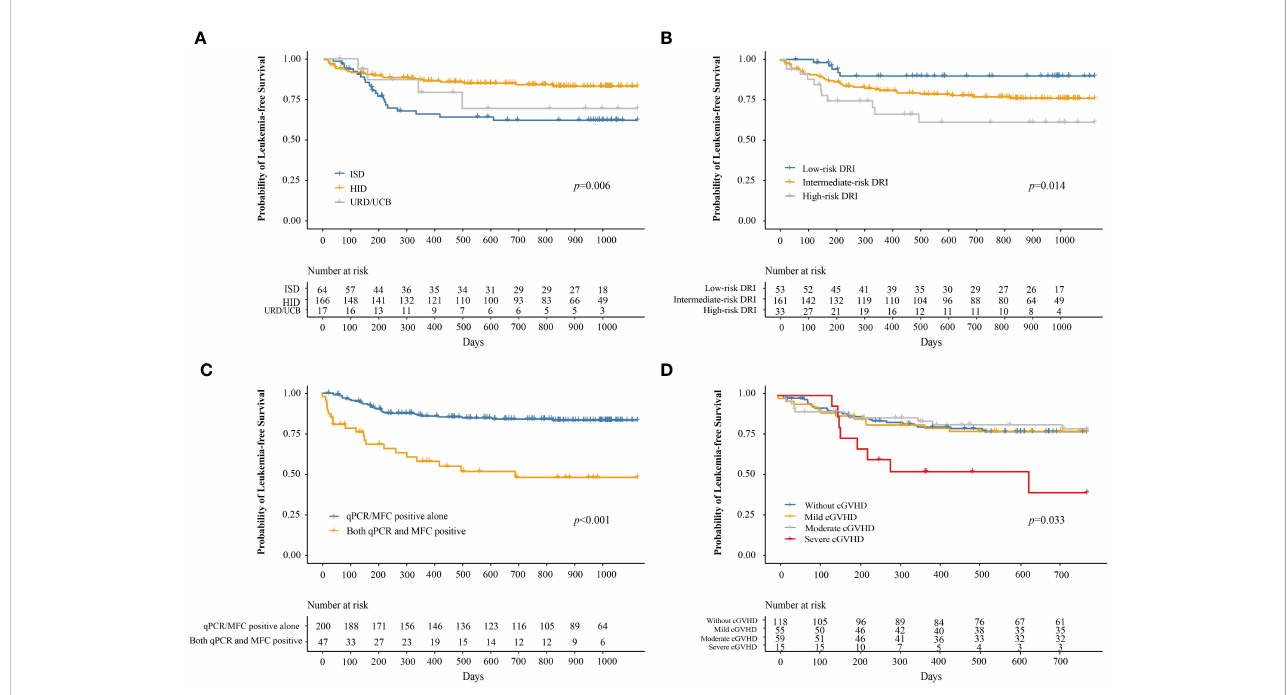
FIGURE 5 The probability of LFS after preemptive IFN- a therapy for patients receiving ISD, HID, and URD/UCB transplantation (A) , for patients in the low-, intermediate-, and high-risk DRI groups (B) , for patients with qPCR/MFC positive alone and both qPCR and MFC positive (C) , and for patients without cGVHD, with mild, moderate, and severe cGVHD (D) . LFS, leukemia-free survival; IFN- a , interferon- a ; ISD, identical sibling donor; HID, haploidentical donor; URD, unrelated donor; UCB, unrelated cord blood; qPCR, quantitative polymerase chain reaction; MFC, multiparameter fl ow cytometry; DRI, disease risk index; cGVHD, chronic graft-versus-host